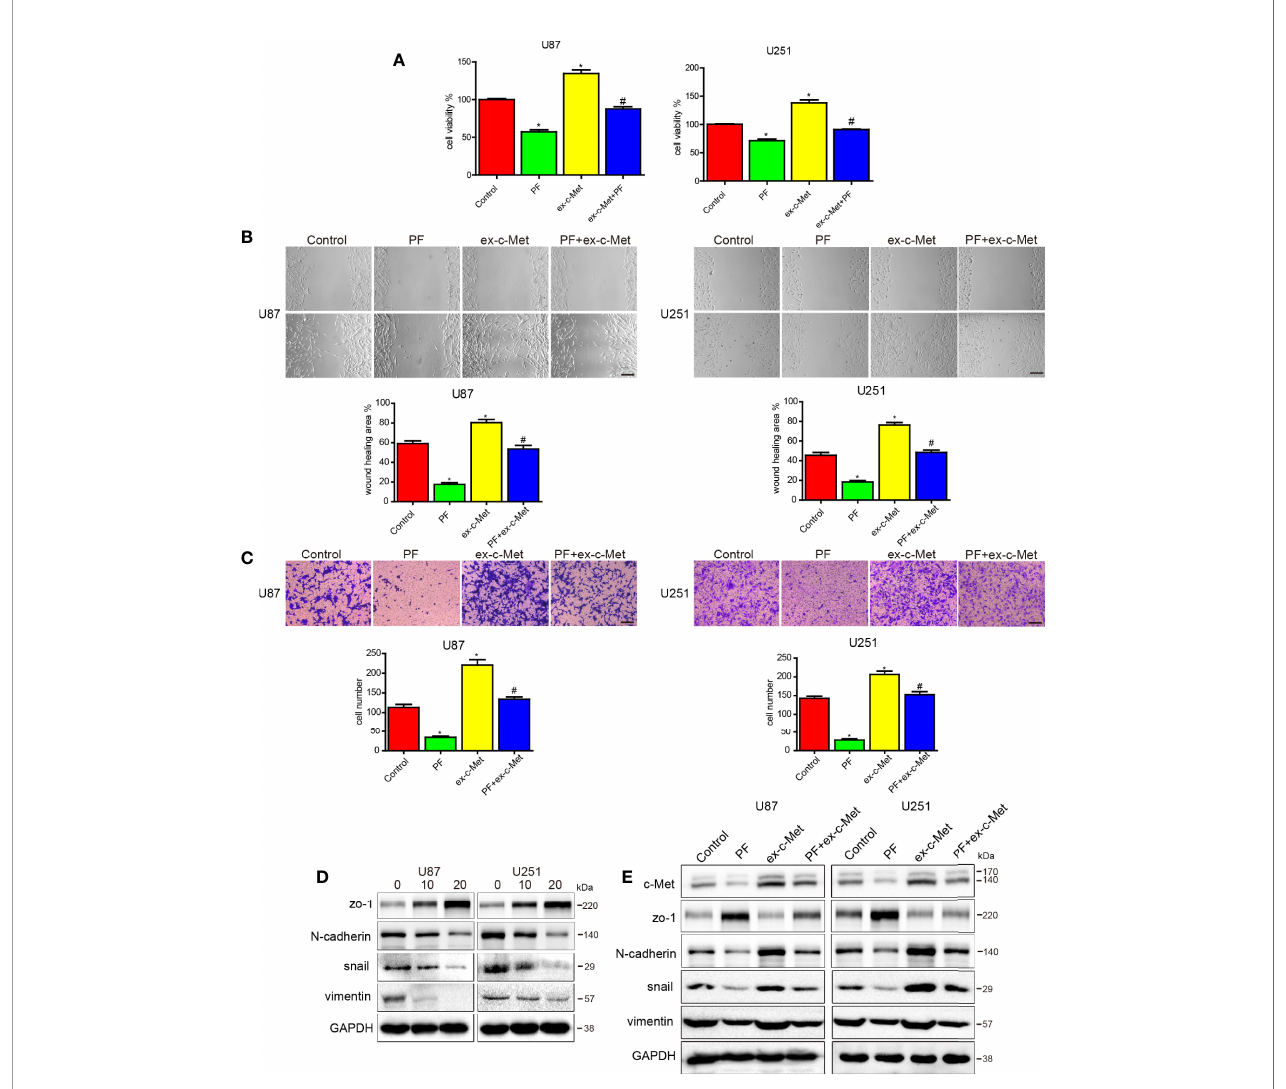
FIGURE 2 | c-Met overexpression reduced the effects of paeoni fl orin on cell proliferation, migration and invasion and EMT. (A) U87 cells and U251 cells transfected with c-Met or vector plasmids for 12 hours were harvested, and 4×10 3 cells were seeded in a 96-well plate and then incubated with 10 m M paeoni fl orin or PBS for 24 hours. CCK-8 assay was used to detect cell proliferation. (B) U87 cells and U251 cells transfected with c-Met or vector plasmids for 12 hours were harvested, and 1×10 5 cells were seeded in 6-well plates and then incubated with 10 m M paeoni fl orin or PBS for 24 hours. Wound-healing assay was performed to detect U87 and U251 cell migration. (C) U87 cells and U251 cells transfected with c-Met or vector plasmids for 12 hours were harvested, and 2×10 4 cells were seeded in a transwell chamber. Transwell assay was performed to evaluate U87 and U251 cell invasion ability. (D) U87 and U251 cells were incubated with the indicated concentration of paeoni fl orin for 24 hours. Western blotting was performed to examine protein expression. (E) U87 and U251 cells were transfected with c-Met or vector plasmids for 12 hours then treated with 20 m M paeoni fl orin for 24 hours. Western blotting was performed to examine protein expression. Control: transfected with vector; paeoni fl orin: transfected with vector+20 m M paeoni fl orin; ex-c-Met: transfected with c-Met; ex-c-Met+paeoni fl orin: transfected with c-Met+20 m M paeoni fl orin. *P<0.05 vs control. # P<0.05, compared with either paeoni fl orin treatment or c-Met transfection